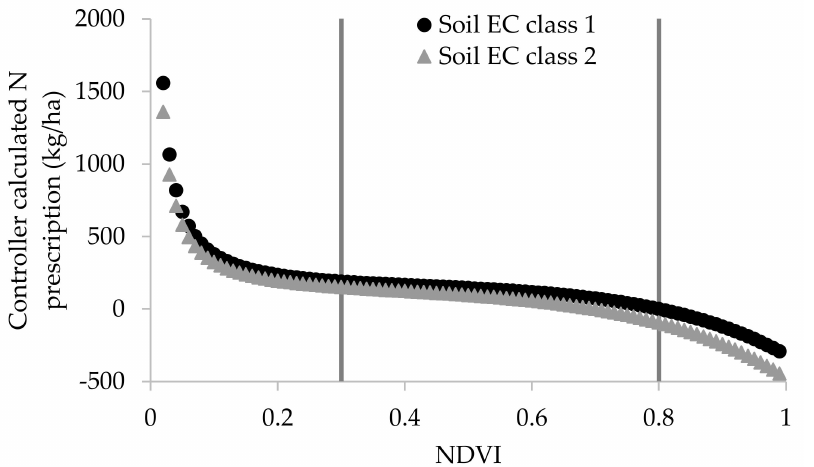
Figure 8. Controller–calculated N prescriptions (kg/ha) vs. controller-recorded NDVI values. The ver- tical lines represent the typical range of NDVI values observed in cotton. The average application rate for the full range of NDVI values was 179.75 kg/ha for the soil EC classification 1 and 106.49 for the soil EC classification 2.